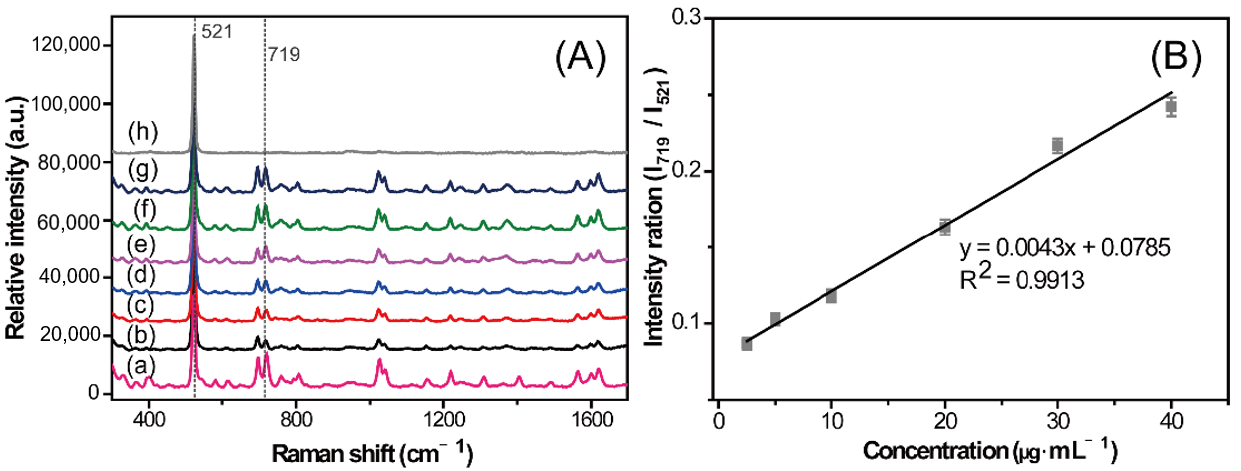
Figure 5. Calibration curve of carbamazepine (CBZ) using the established methods: ( A ) surface- enhanced Raman spectroscopy (SERS) spectra of CBZ ( a ), silicon ( h ), and different concentrations of CBZ simulated samples (( b – g ): 2.5, 5, 10, 20, 30, and 40 µ g · mL − 1 , respectively). ( B ) The SERS intensity ratio of peaks 719 and 521 cm − 1 were used to generate a calibration curve. The figure shows the signal at the range of 2.5–40 µ g · mL − 1 with an R 2 value of 0.9913. Error bars shows